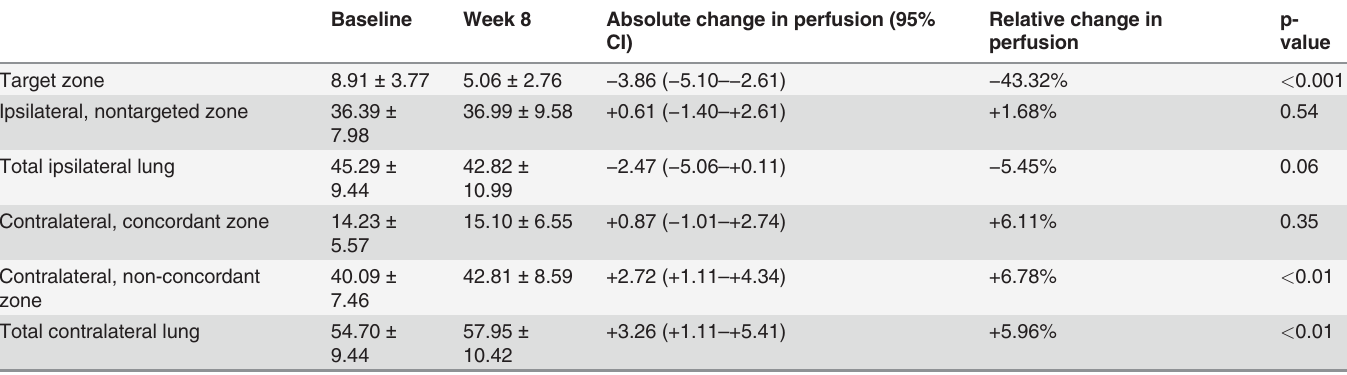
Table 2. Change in perfusion of single zones from baseline to eight weeks after EBV treatment.